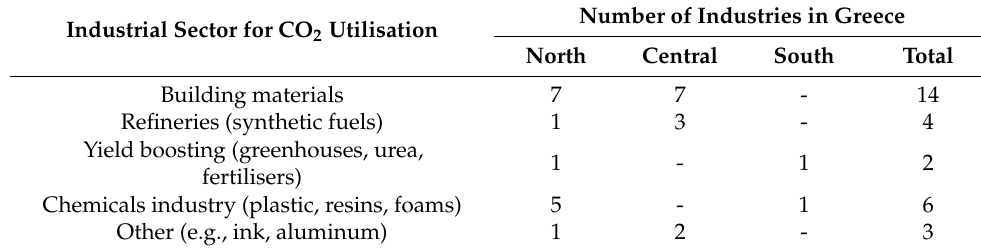
Table 5. Potential Greek industries available for CO 2 utilisation. Industrial Sector for CO 2